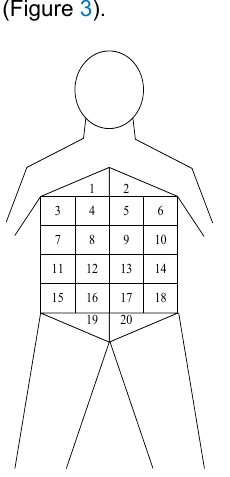
Figure 3. Encoding of the location of abdominal pain The expert-physicians provided the decision tree depict- ed in Figure 4 [31]. The number of leafs are the numbers of the diagnosis presented above. The numbers in the nodes correspond with the following diagnosis: